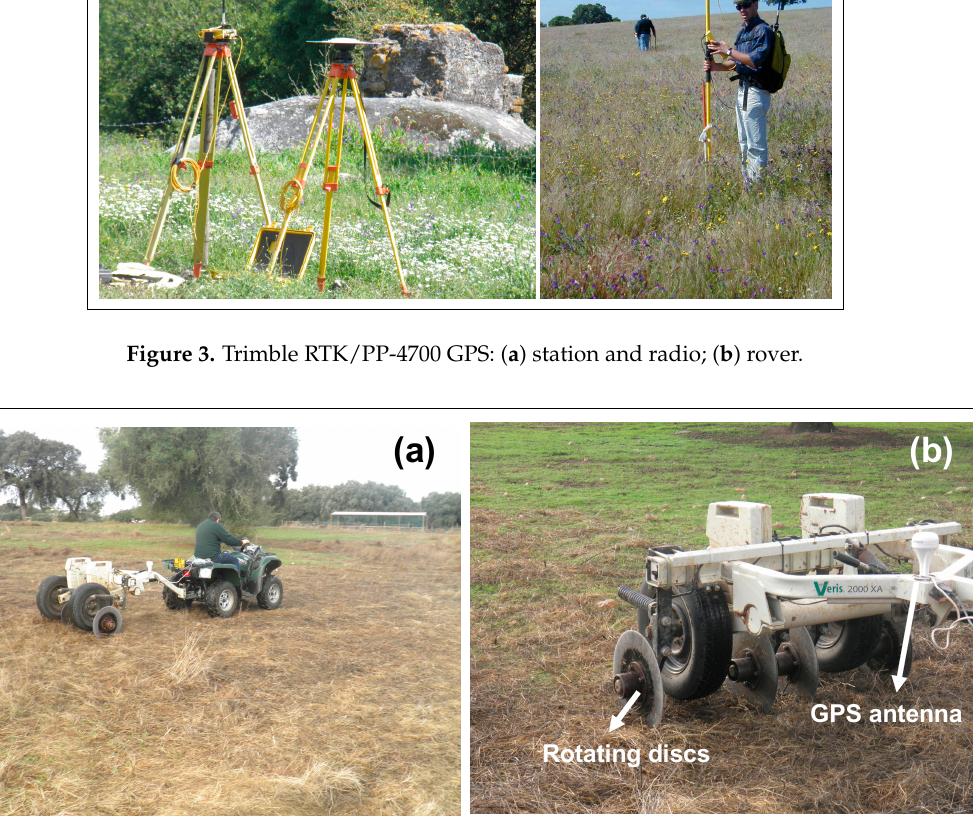
Figure 3. Trimble RTK/PP-4700 GPS: ( a ) station and radio; ( b ) rover.